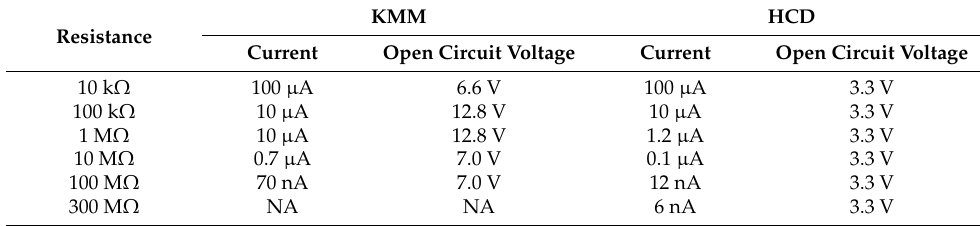
Table 2. Comparison of the measurement currents and voltages for resistors of different resistances. Resistance